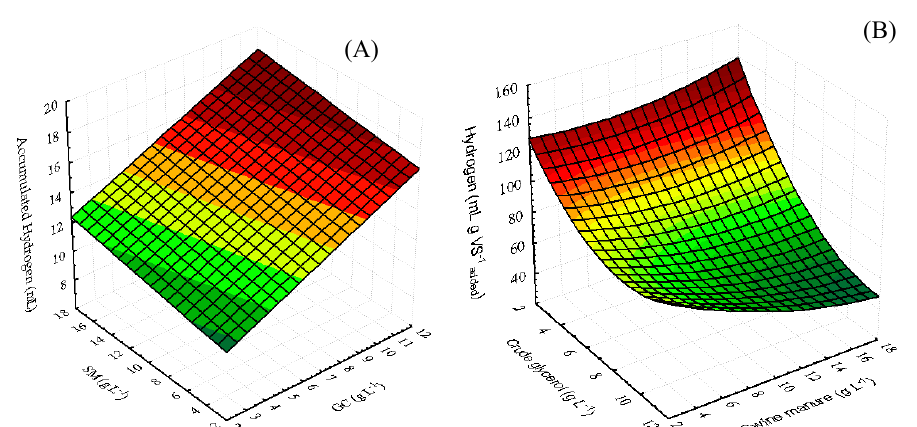
Figure 5. Results of accumulated hydrogen, applying the response surface methodology (RSM). ( A ) The hydrogen production yield per gram of volatile solid; ( B ) accumulated hydrogen productivity, in relation to the mixture of crude glycerol and swine manure.